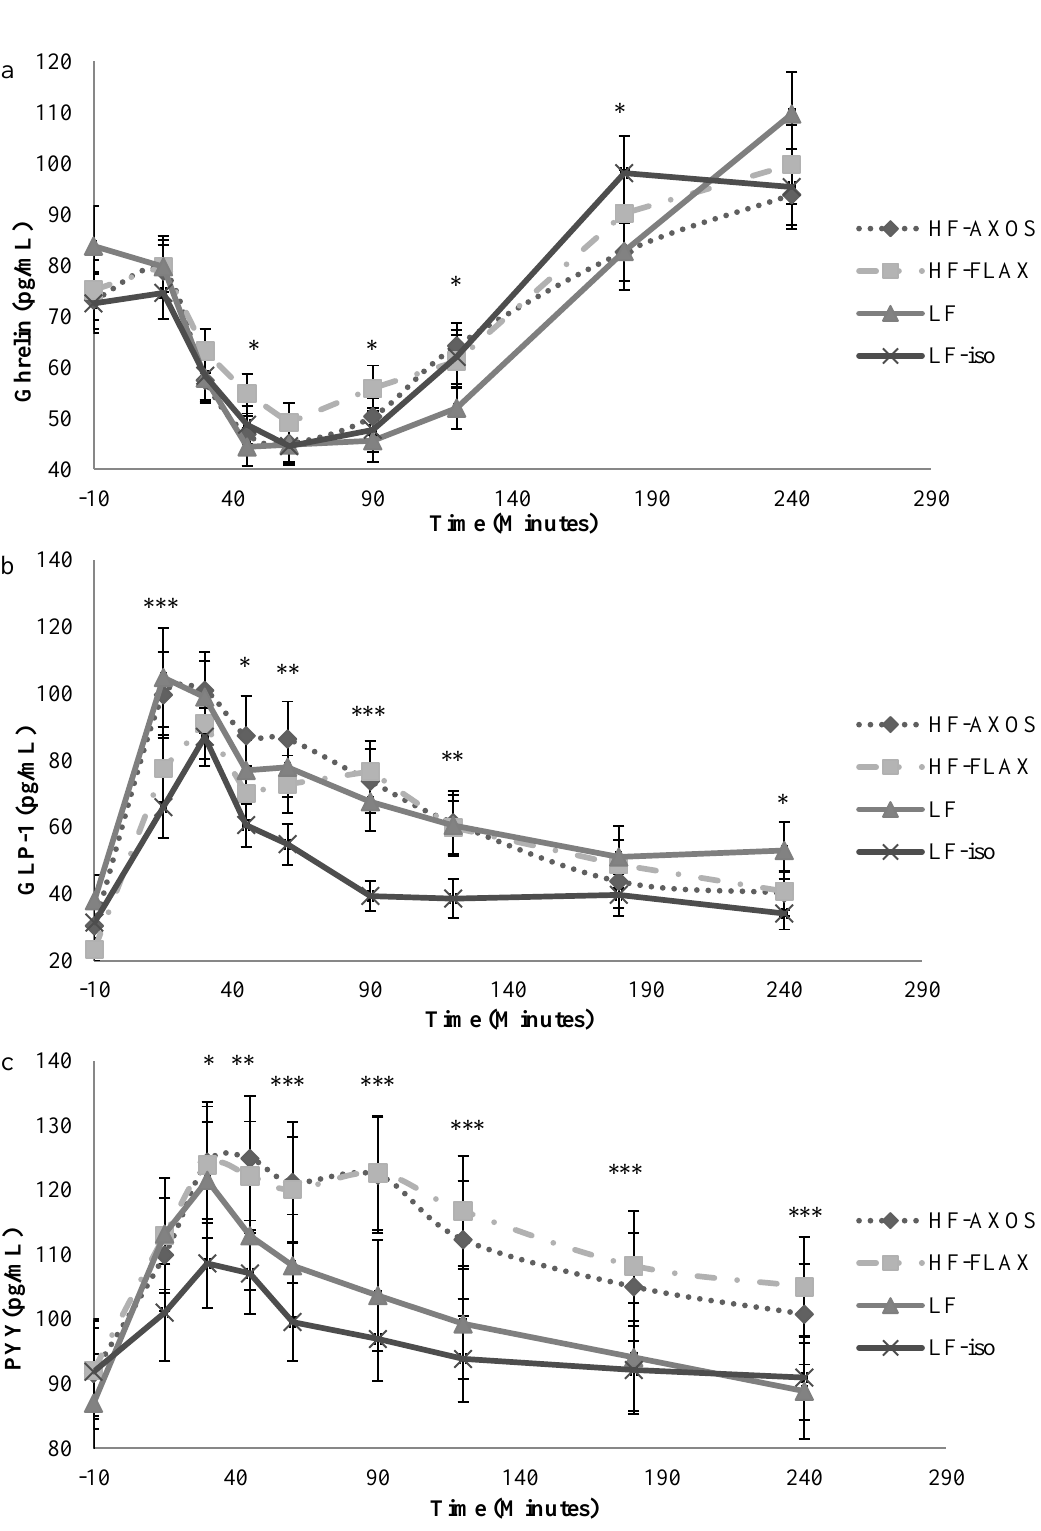
Figure 2. Plasma hormone concentrations at selected time points: ( a ) active ghrelin, ( b ) active GLP-1, ( c ) total PYY. Significant differences among groups are signified as follows: *** p < 0.001; ** p < 0.01; * p < 0.05. LF: low-fiber RTEC; HF-AXOS: high-fiber (HF) RTEC with AXOS fiber; HF-FLAX: high-fiber (HF) RTEC with FLAX fiber; LF-iso: isocaloric RTEC to that of the HF